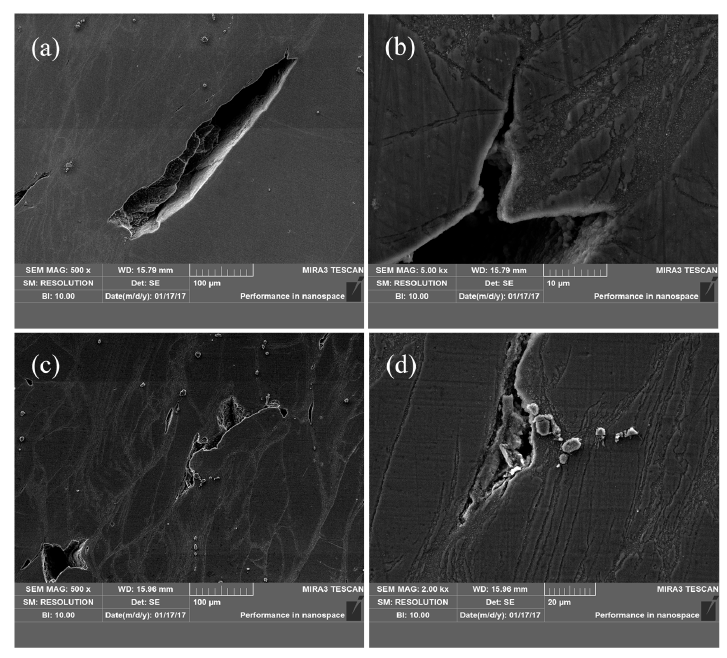
Figure 14. SEM images of AZ91 alloy: ( a ) 523 K and 1 s − 1 , ( c ) 523 K and 0.1 s − 1 ; ( b , d ) high magnification of ( a , c ).